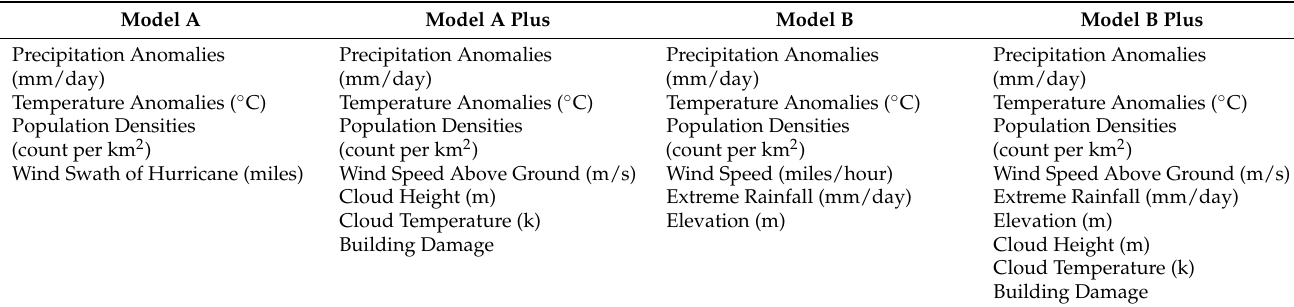
Table 2. Input variables of different geospatial